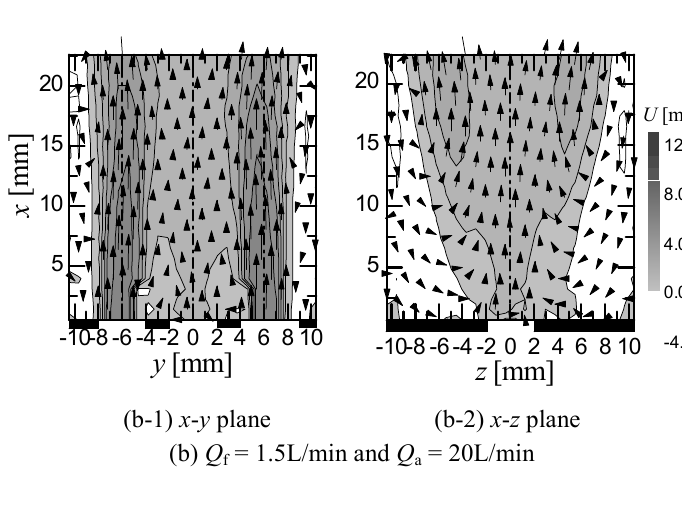
Fig. 4 Streamwise velocity U contours and velocity vectors in R60-s0 case.